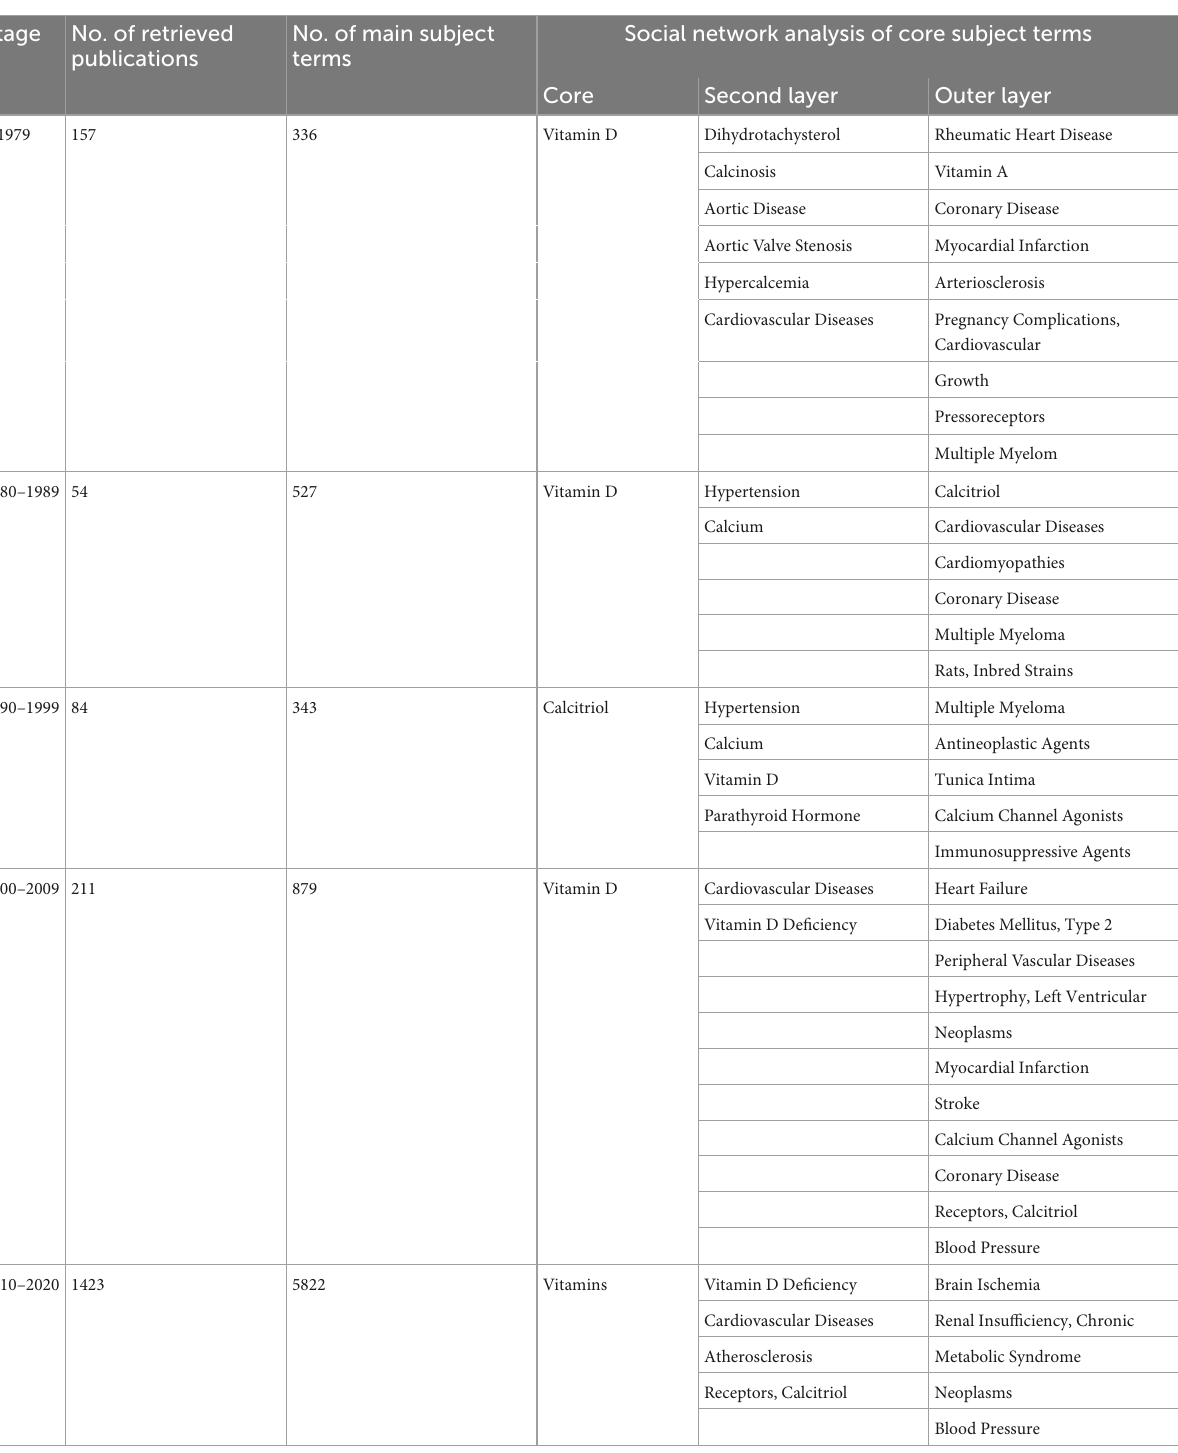
TABLE 1 Literature analysis of “vitamin D AND cardiovascular disease” in PubMed as of December 2020.